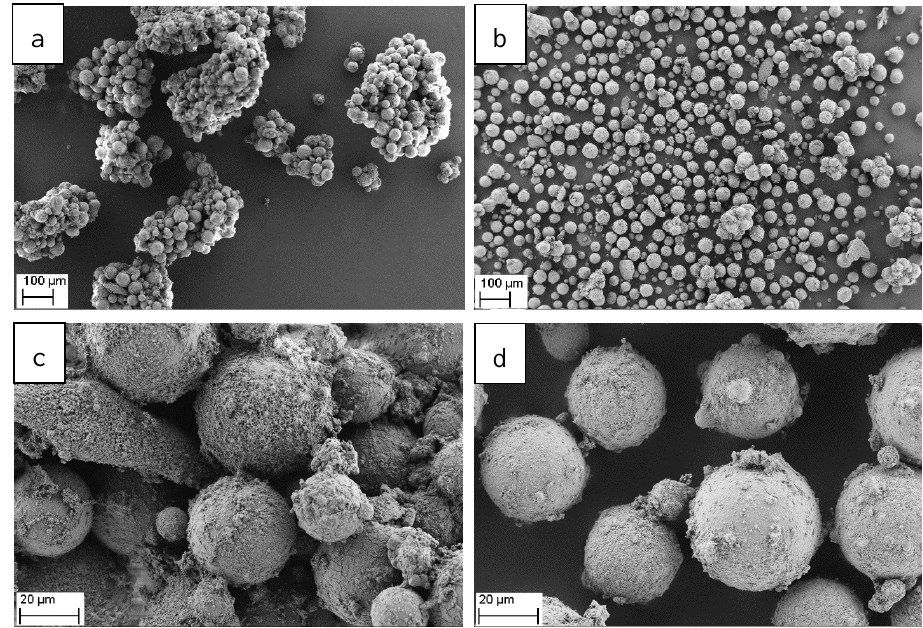
Figure 10. SEM images of the untreated (( a,c ) and post-treated (Turbula® Mixer; ( b,d )) SMGS Type S (Experiment 2 A). Breaking off of the agglomerates and no change in surface morphology is evident.